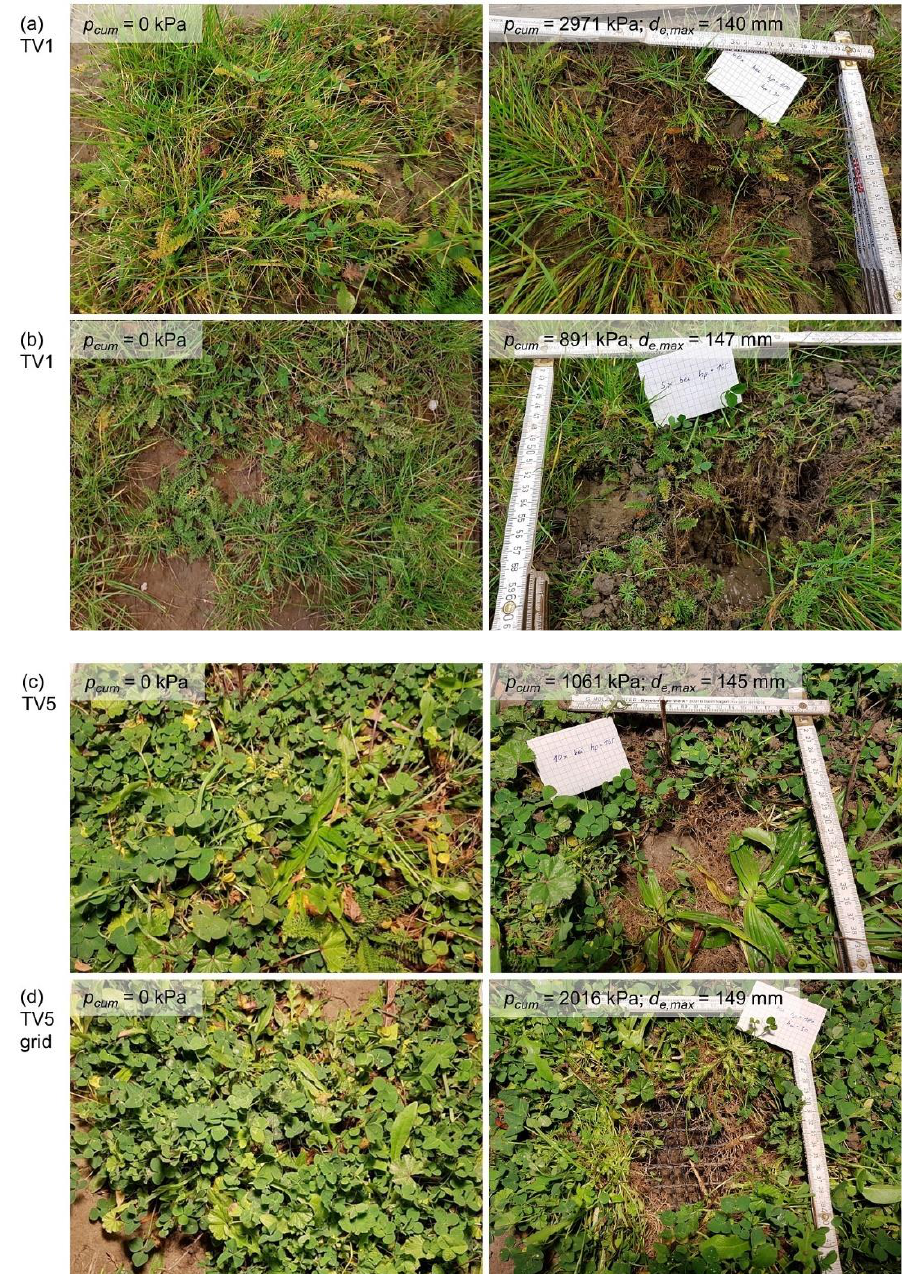
Figure 6. Erosion patterns during the wave impact simulations: Test surfaces of TV1 ( a,b ), TV5 ( c ), and TV5grid ( d ) before (left) and after testing (right). TV1 = species-poor grass-dominated mixture, TV5 = species-rich herb-dominated EcoDike mixture, and grid = geogrid reinforcement (photos: Delfino, 2018).